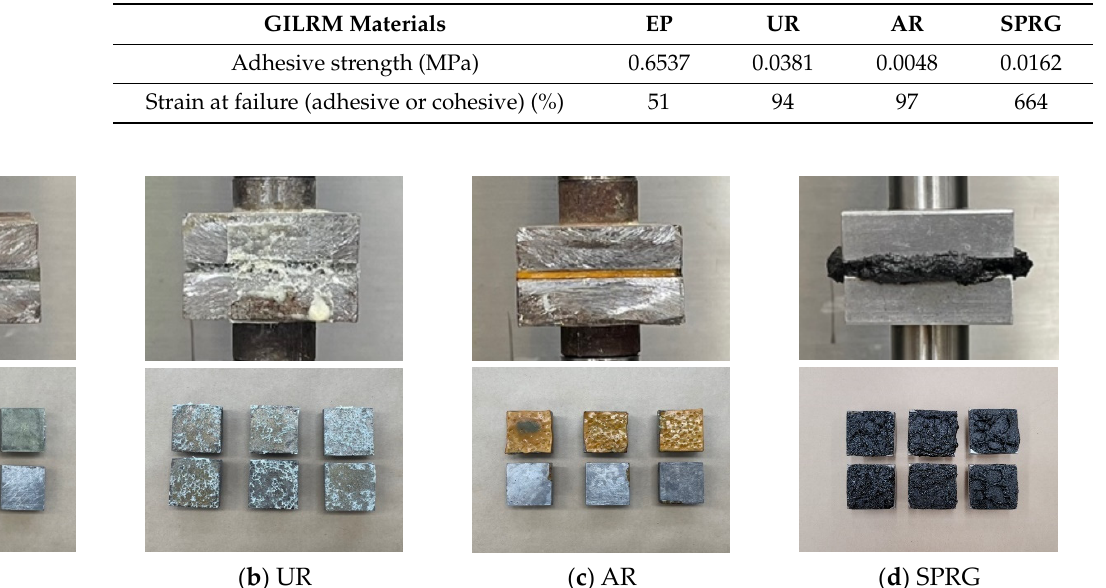
Table 3. Adhesive performance test result of 4 materials.